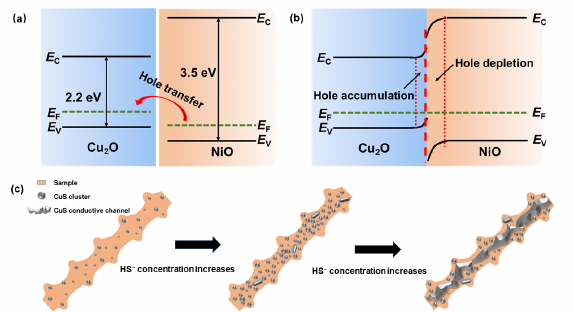
Fig. 6. Schematic diagrams of the energy band structure of Cu 2 O and NiO (a) before and (b) after contact. (c) Schematic diagram of the evolution of vulcanization reaction of Cu 2